Question: Produce a descriptive caption suitable for publication.
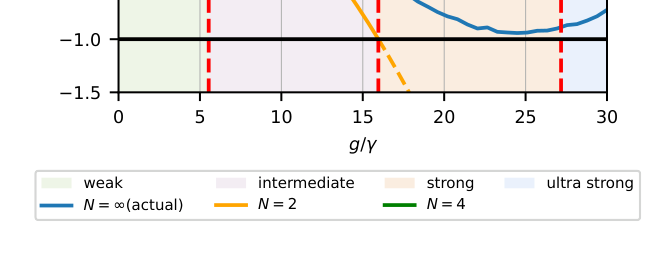
Answer: The qubit coherence under RTN vs the cou- pling strength between system and noise. The blue line shows the actual calculation using Monte-Carlo simulation. The green and orange lines show the theoretical calculation using the Dyson expansion with truncation orders N = 2, 4 respectively. The dotted red lines define the boundaries be- tween the different noise strength regions.